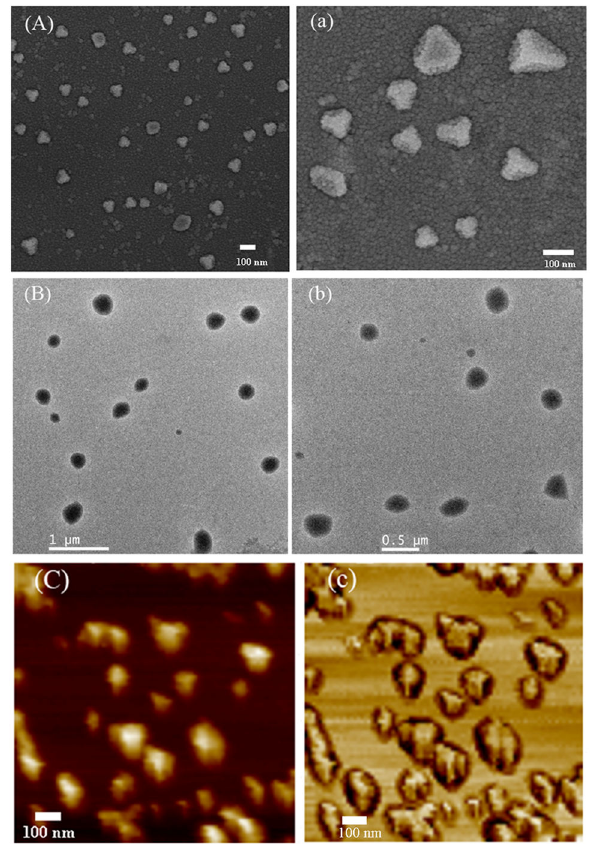
Figure 4. AFM, SEM and TEM images of DPG particles with Nano-size. (A): SEM images of DPG particles at 40,000× magnification; (a): SEM images of DPG particles at 100,000× magnification (B): TEM images of DPG particles at 4,000× magnification; (b): TEM images of DPG particles at 8,000× magnification; (C): AFM topographical images of DPG particles; (c): AFM phase images of DPG